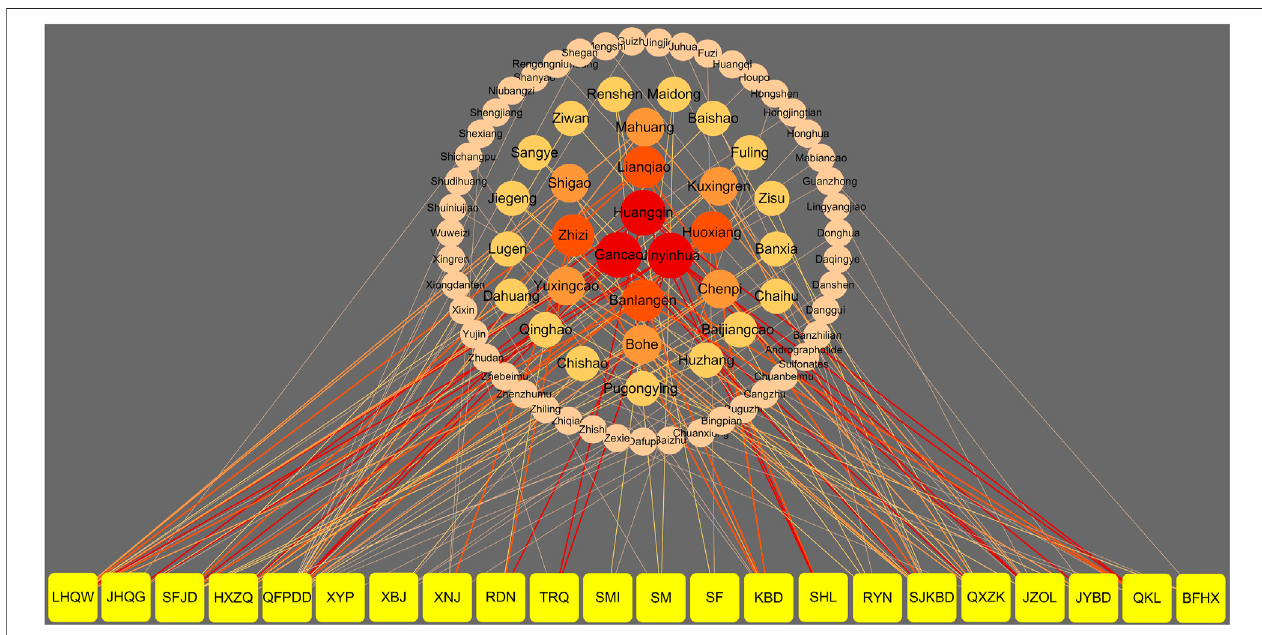
FIGURE 2 | The relationship of the recommended CPMs and their constituents. Note: the yellow nodes represent CPMs. The other color nodes represent constituentsofCPMs.Thesizeanddarknessofthenodesrepresenttheappearancefrequencyofeachconstituent.Thedarknessofthenodesfromdarktolightandthe size from largetosmallare illustrated indescending orderof appearance frequency. The connecting lines indicate thateach node is related. The width of theconnecting lines was based on the appearance frequency of constituents, and the color and rule were same as the nodes. LHQW: Lianhua Qingwen Capsule; JHQG: Jinhua Qinggan Granules; SFJD: Shufeng Jiedu Capsule; HXZQ: Huoxiang Zhengqi Capsule; QFPDD: Qingfei Paidu decoction; XYP: Xiyanping Injection; XBJ:Xuebijing Injection; XNJ: Xingnaojing Injection; RDN: Reduning Injection; TRQ: Tanreqing Injection; SMI: Shenmai Injection; SM: Shengmai Injection; SF: Shenfu Injection; KBD: Kangbingdu Granules; SHL: Shuanghuanglian Oral Liquid; RYN: Reyanning Oral Liquid; SJKBD: Siji Kangbingdu Mixture; QXZK: Qingxuan Zhike Granules; JZOL: Jinzhen Oral Liquid; JYBD: Jinye Baidu Granules; QKL: Qingkailing Injection; BFHX: Bufei Huoxue